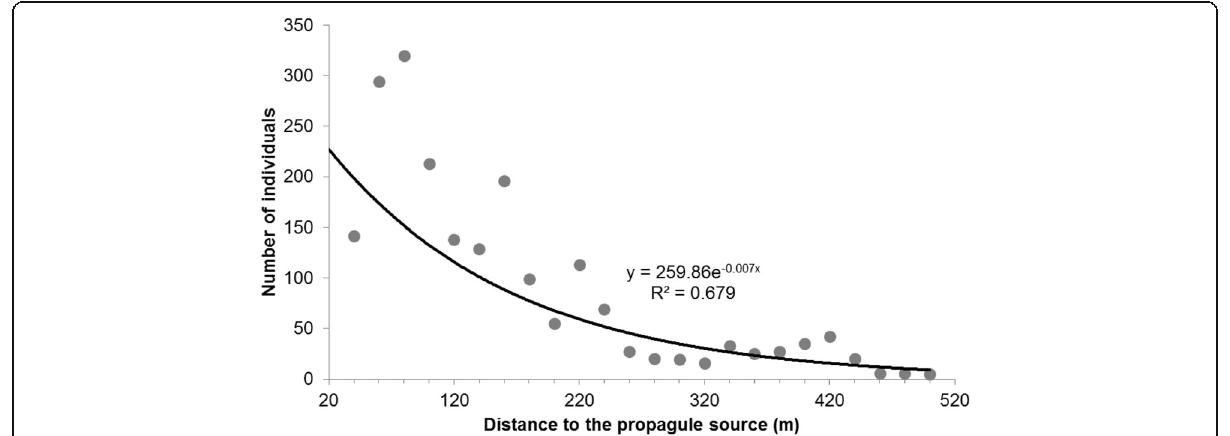
Fig. 3 Distribution of individual abundance in relation to the distance to the propagule sources